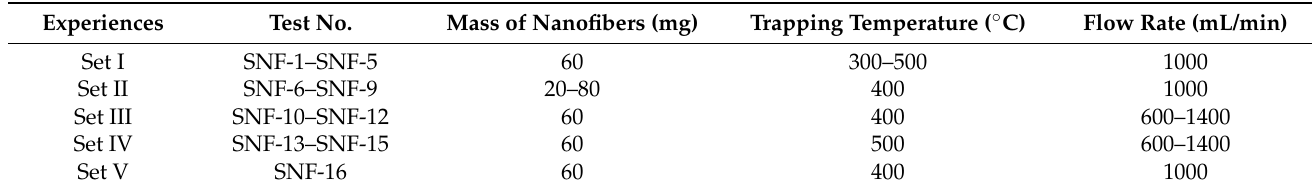
Figure 1. Schematic diagram of aerosol capture system. Table 1. Experimental conditions for different aerosol capture experiments.